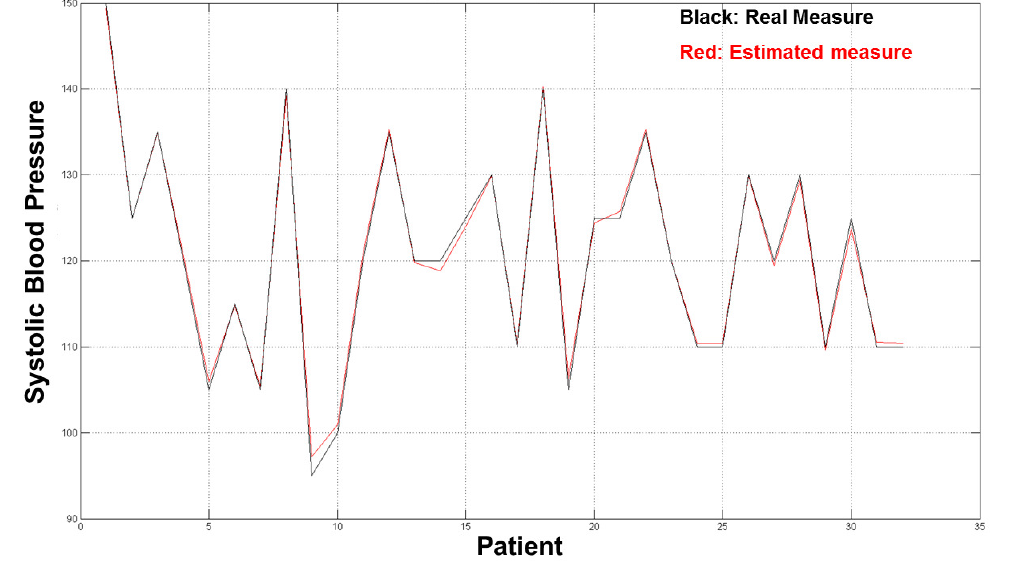
Figure 10. SBP estimation performance